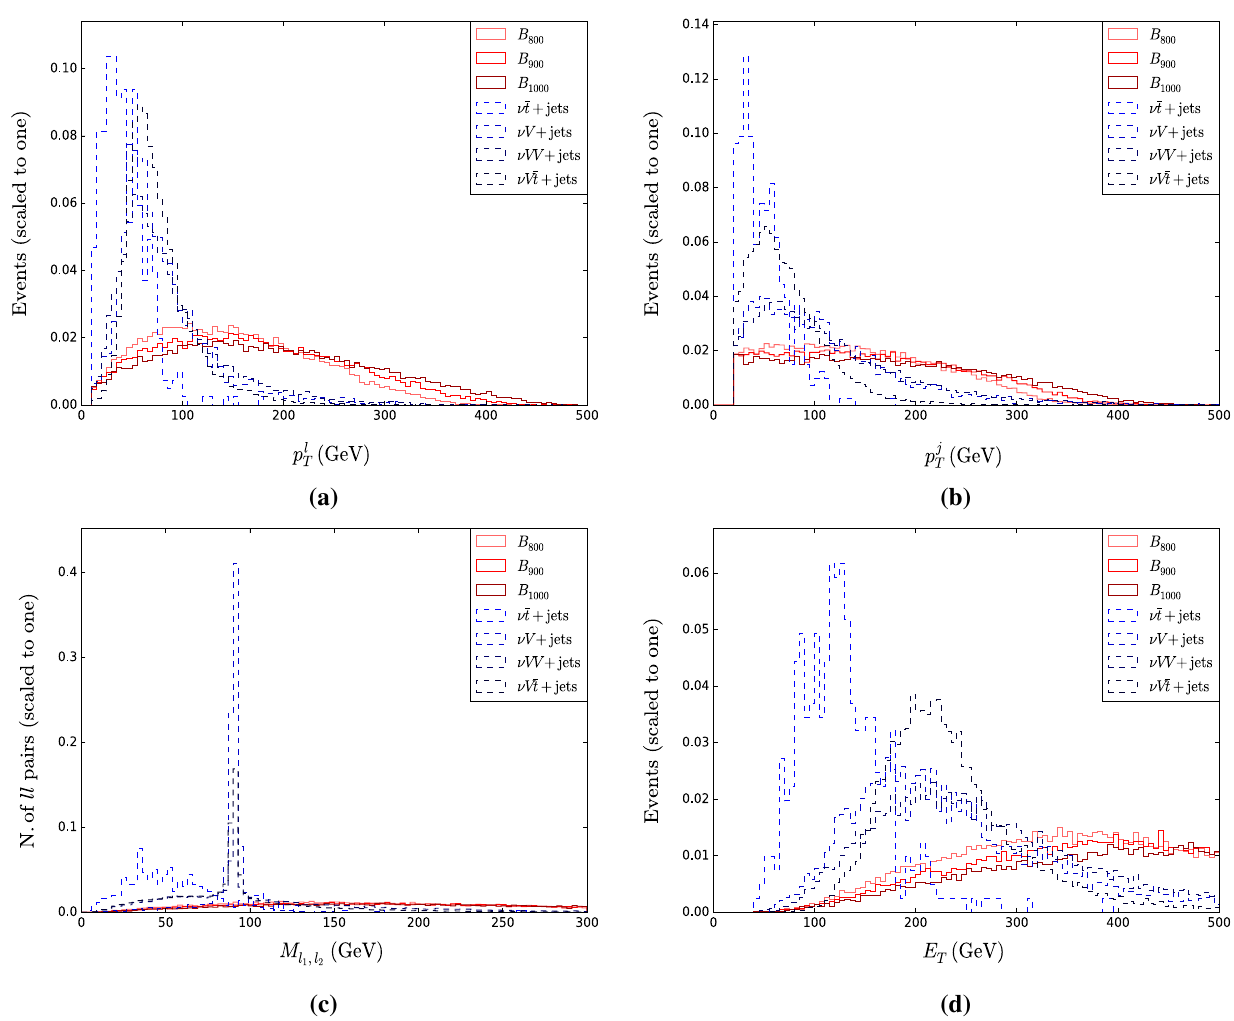
Fig. 7 Normalized distributions of p l